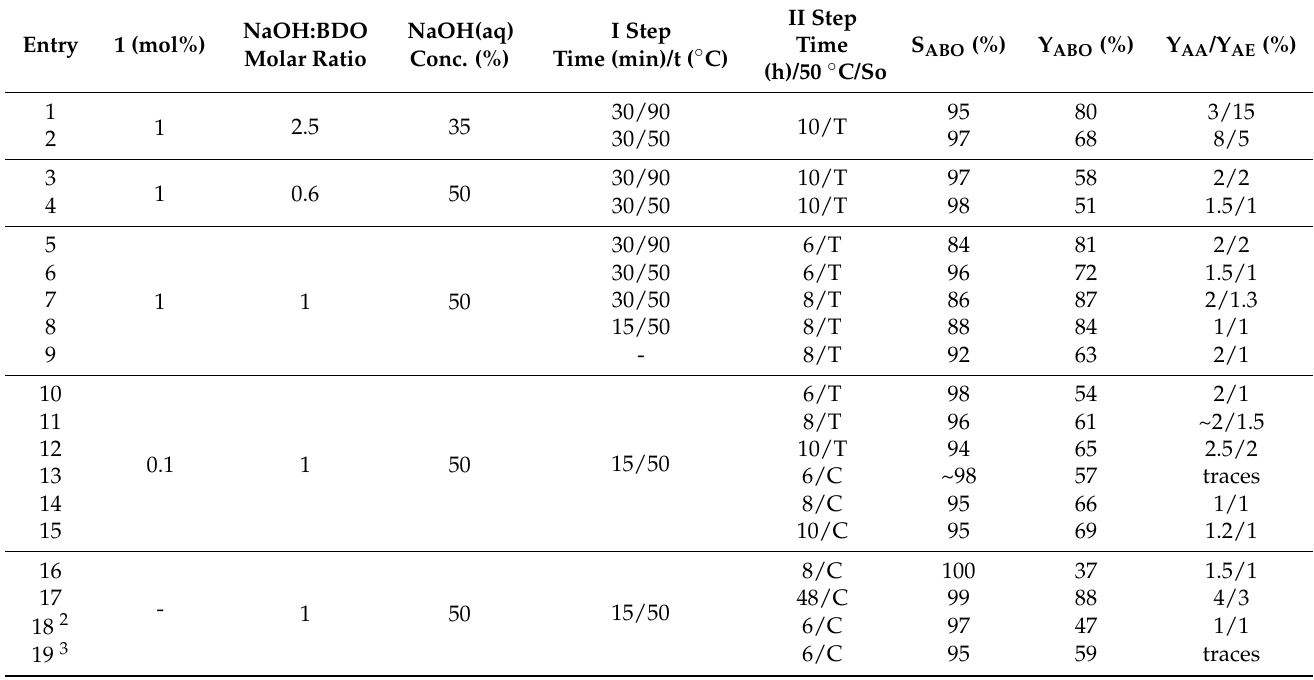
1 The reaction conditions: 0.3 mole scale of BDO, the molar ratio of AC:BDO = 3.5, the volume ratio of solvent: AC = 1.5 (So—solvent, T—toluene, CH—cyclohexane), mechanical paddle stirrer. 2 The NaCl was added in the molar ratio of NaCl: BDO = 0.5. 3 The NaCl was added in the molar ratio of NaCl: BDO =